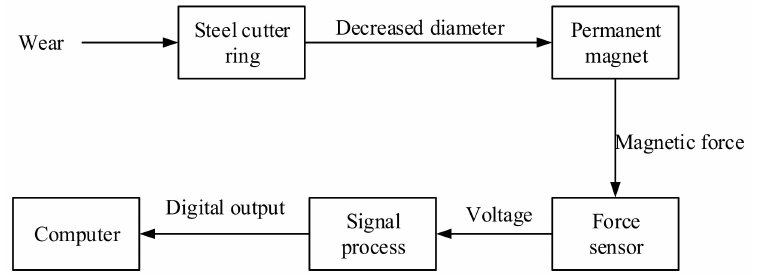
Figure 1. A step-by-step block diagram describing the working principle of the detection system for cutter wear.